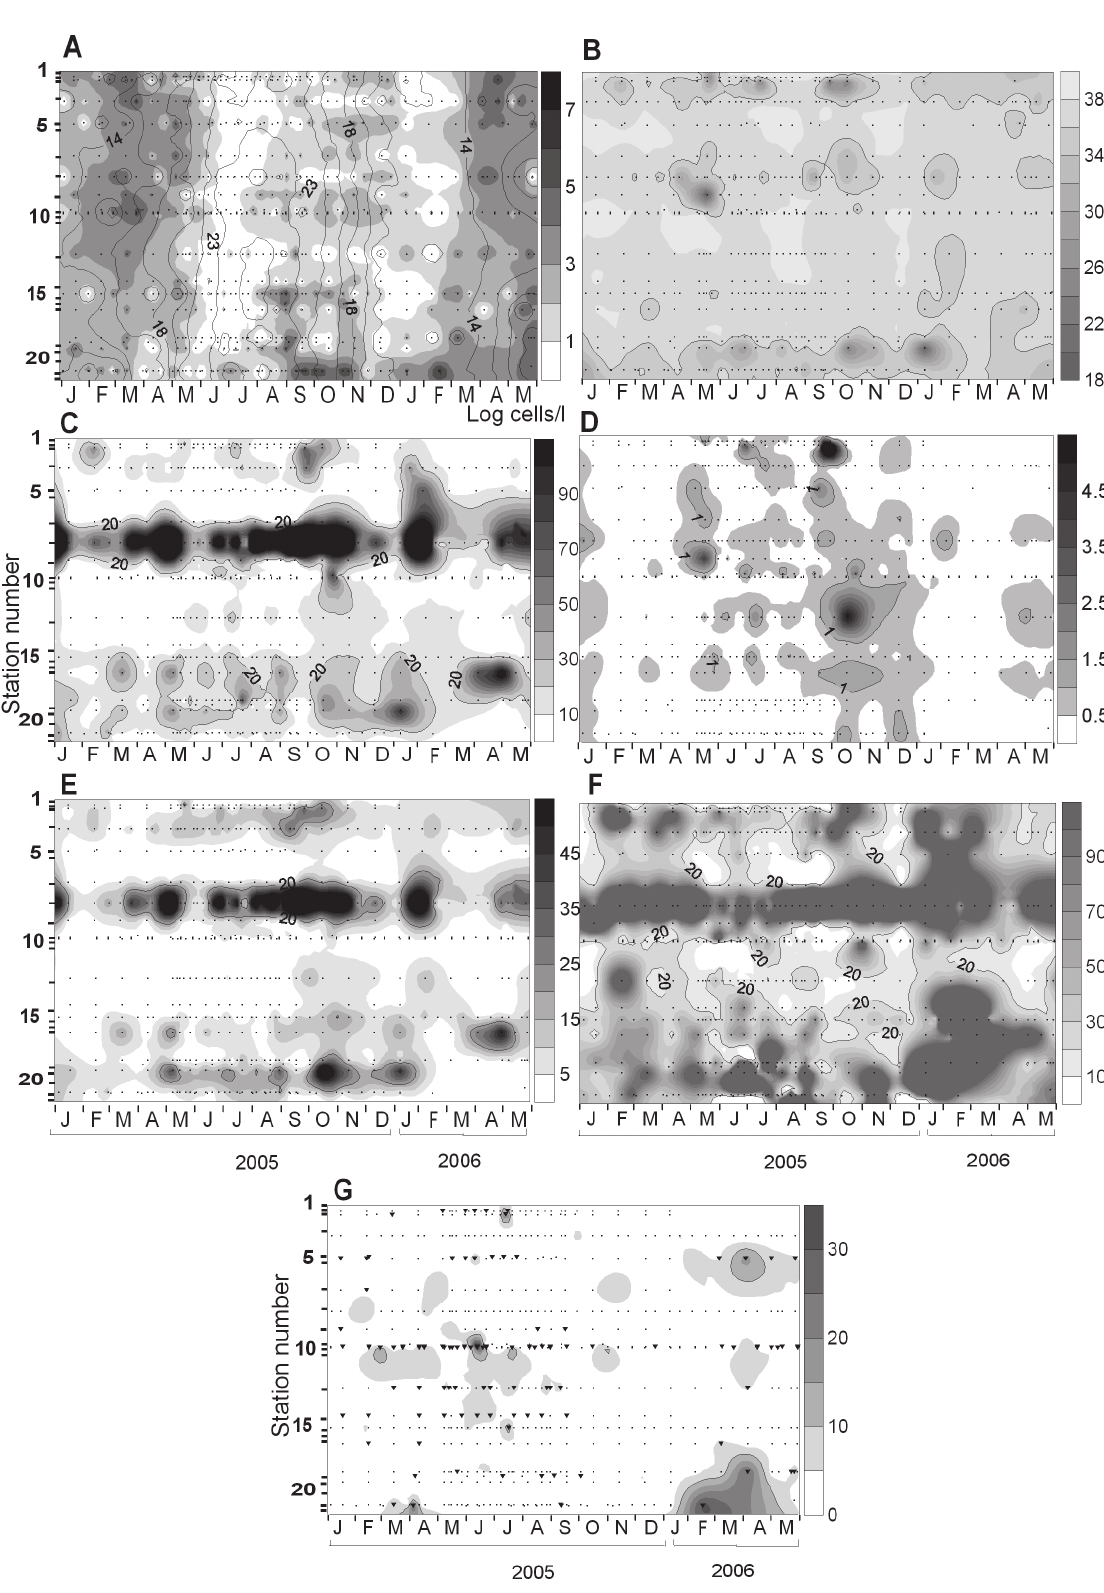
Fig . 6. – temporal-spatial distribution of; a) Pseudo-nitzschia spp and temperature; B) salinity. the dots on the graphs are the sampling sta- tions c) din µm; d)